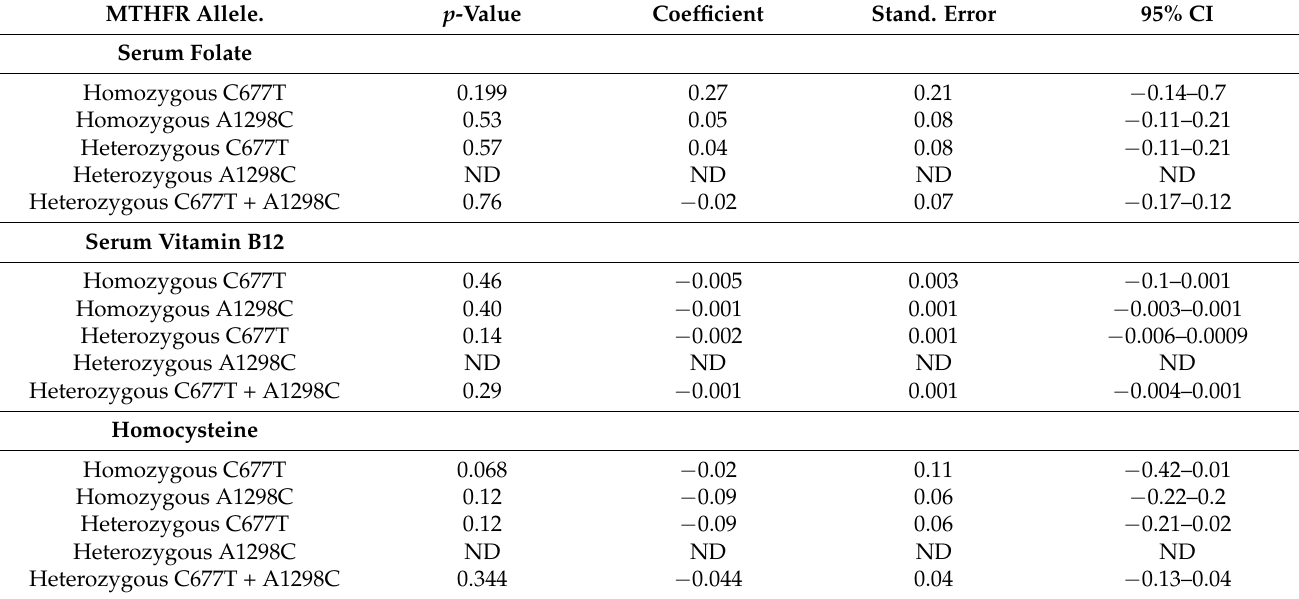
Table 4. Serum pathology compared to MTHFR mutations: logistic regression was used to assess the relationship between individual MTHFR mutations and serum blood tests. MTHFR Allele. p -Value Coefficient Stand. Error 95%